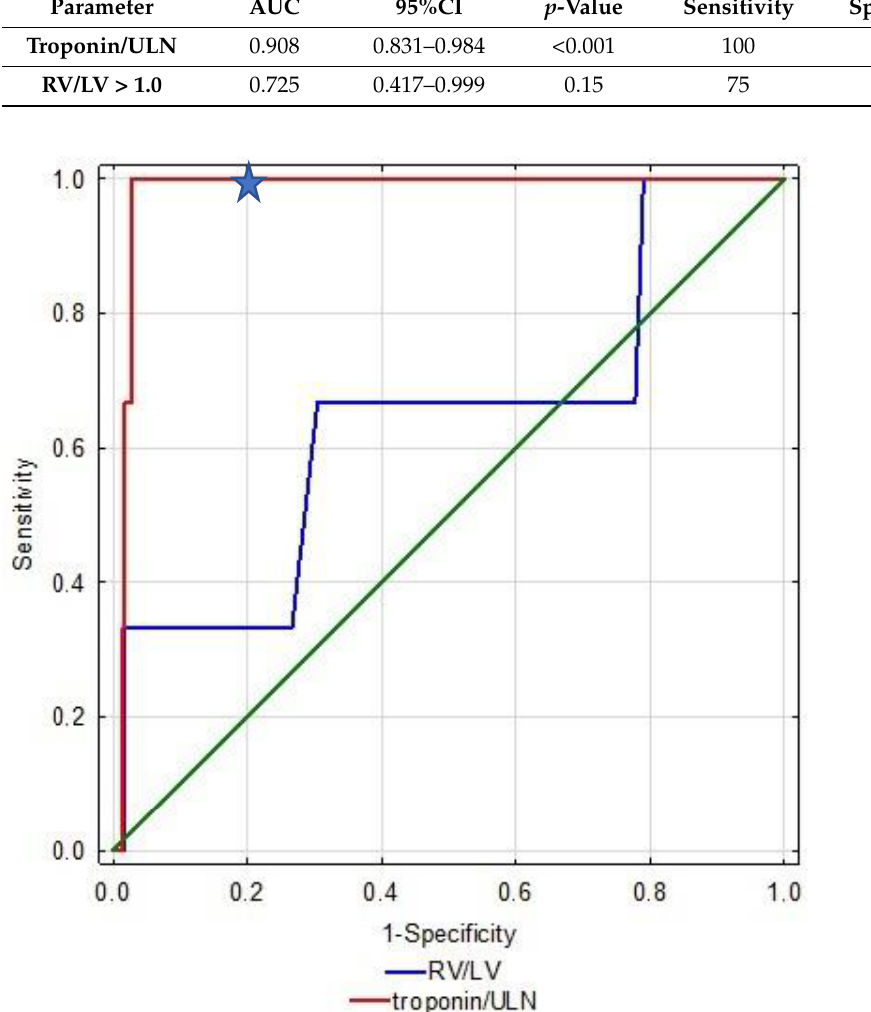
Figure 2. ROC curves for sPESI = 0 pts with full data on troponin levels and RV > LV ratio. ULN — upper limit of normal. The proposed cut-off is marked with a star.